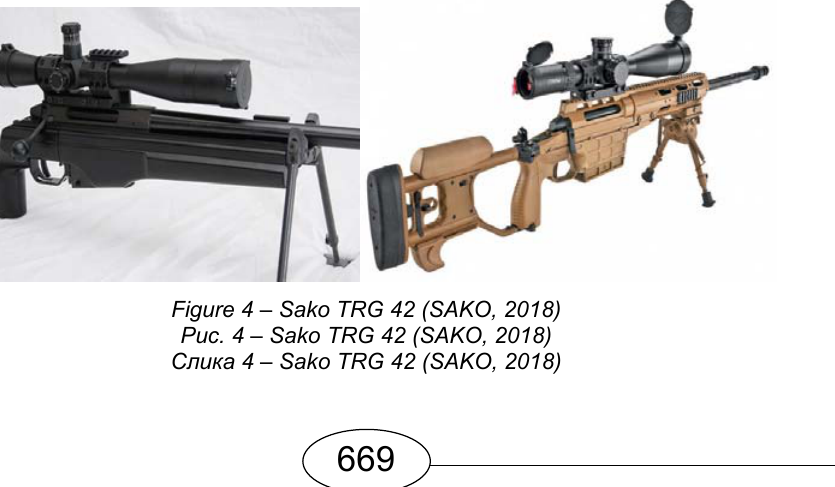
Figure 4 – Sako TRG 42 (SAKO, 2018) Рис . 4 – Sako TRG 42 (SAKO, 2018) Слика 4 – Sako TRG 42 (SAKO,